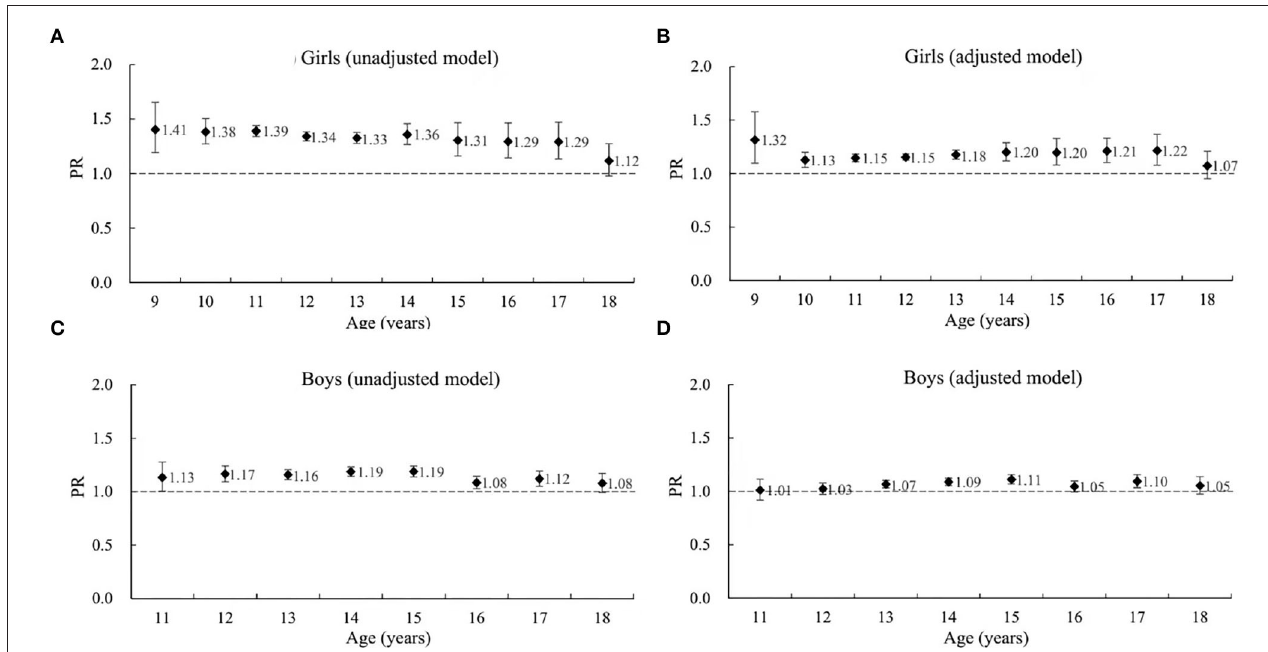
FIGURE 1 | The association between myopia and puberty (menarche for girls and spermarche for boys) status by age in the 1995, 2000, 2005, 2010, and 2014 CNSSCH. (A) Girls (unadjusted model). (B) Girls (adjusted model). (C) Boys (unadjusted model). (D) Boys (adjusted model). PR, prevalence ratio, represents the relative risk of myopia for post-menarche girls (or post-spermarche boys) compared to pre-menarche girls (or pre-spermarche boys). CNSSCH, Chinese National Survey on Students’ Constitute and Health. The total sample sizes for girls and boys were 429,814 and 332,161, respectively. The unadjusted model only adjusted for the cluster effect of school. The adjusted model additionally adjusted for survey year, urban–rural location, regional socioeconomic status (SES) within province and provincial GDP per capita. The error bars represent 95% confidence intervals (CI).